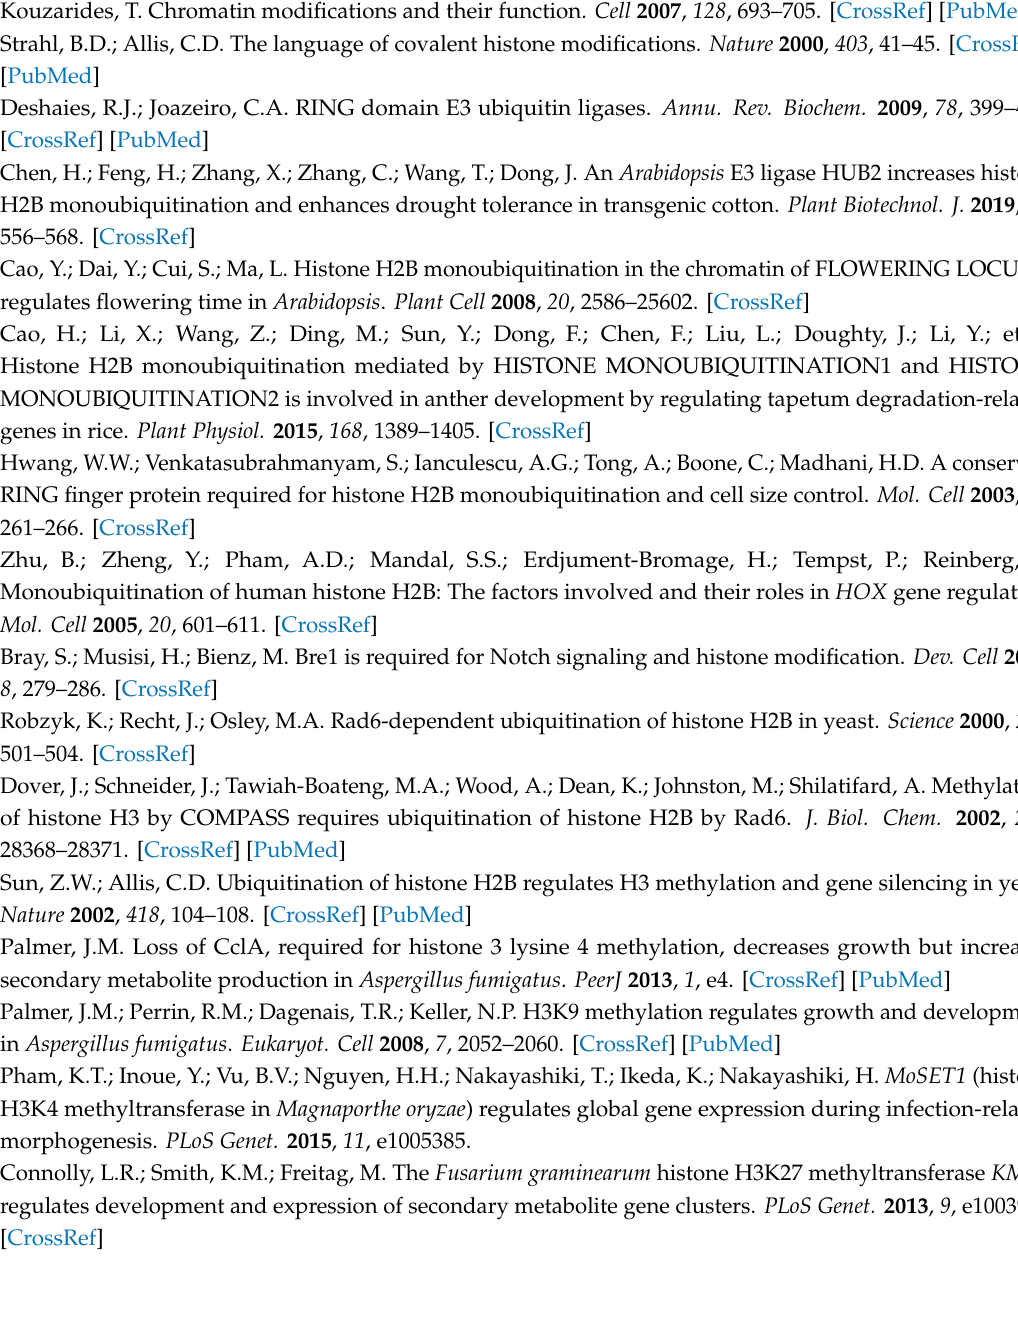
Table S1: Primer sequences used in this study. Table S2: Summary of sequencing reads after filtering. Table S3: Statistics of reads mapping to A. alternata genome by